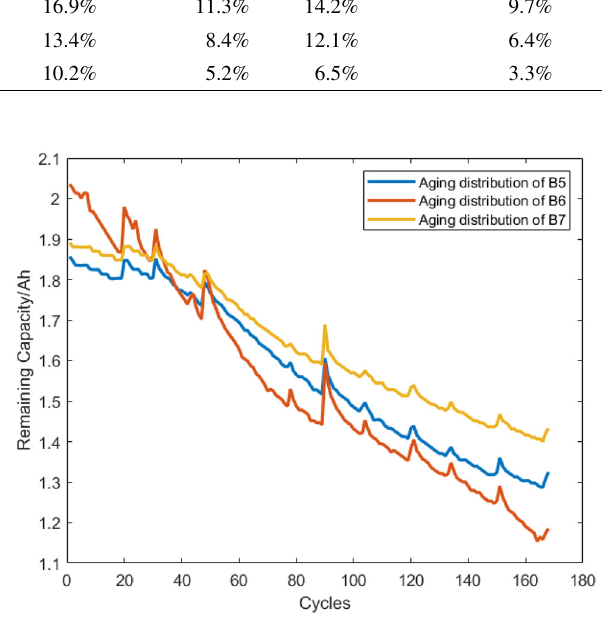
Fig. 8 The ageing distribution of B5, B6, and B7